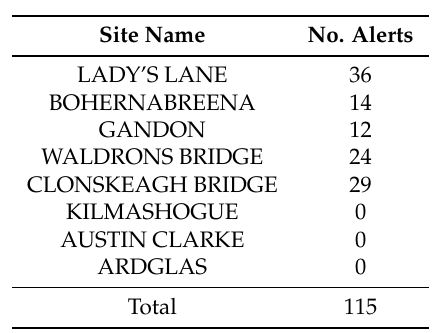
Table 4. Level alerts received from the sensors. Due to the upgrading of the Kinspan app system, no alert was received between 9 January 2016 to 2 August 2016. 22 invalid alerts rose from Bohernabreena after it failed to send valid measurements are not